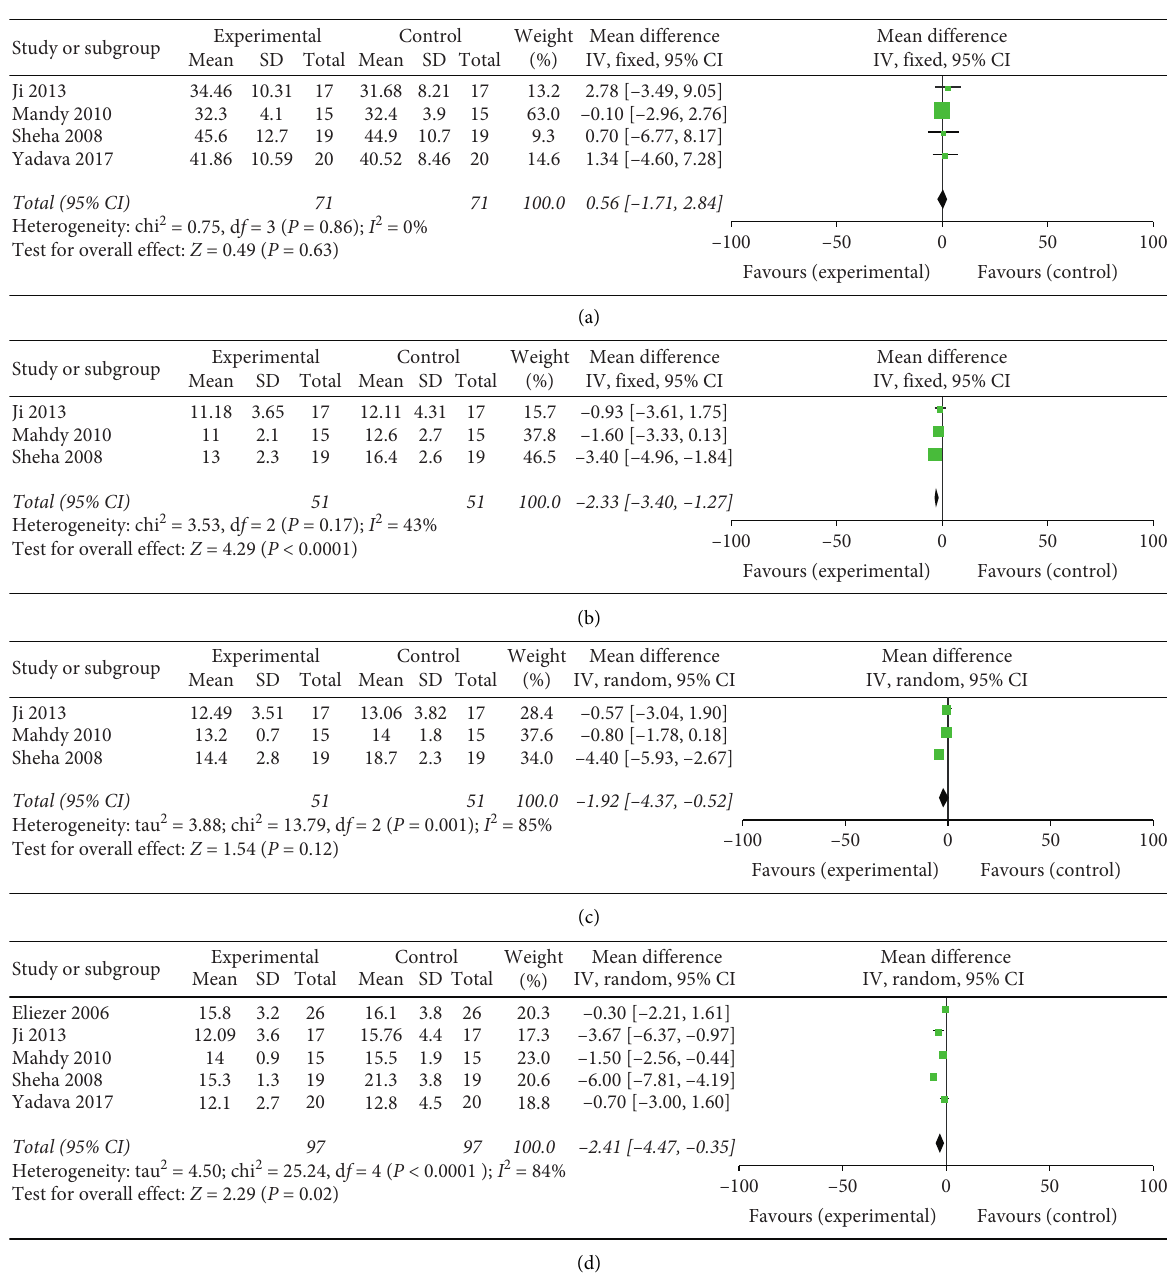
Figure 3: Forest plot comparison of IOP after treatment in the AMTand control group (a) preoperatively, (b) three months postoperatively, (c) six months postoperatively, and (d) one year